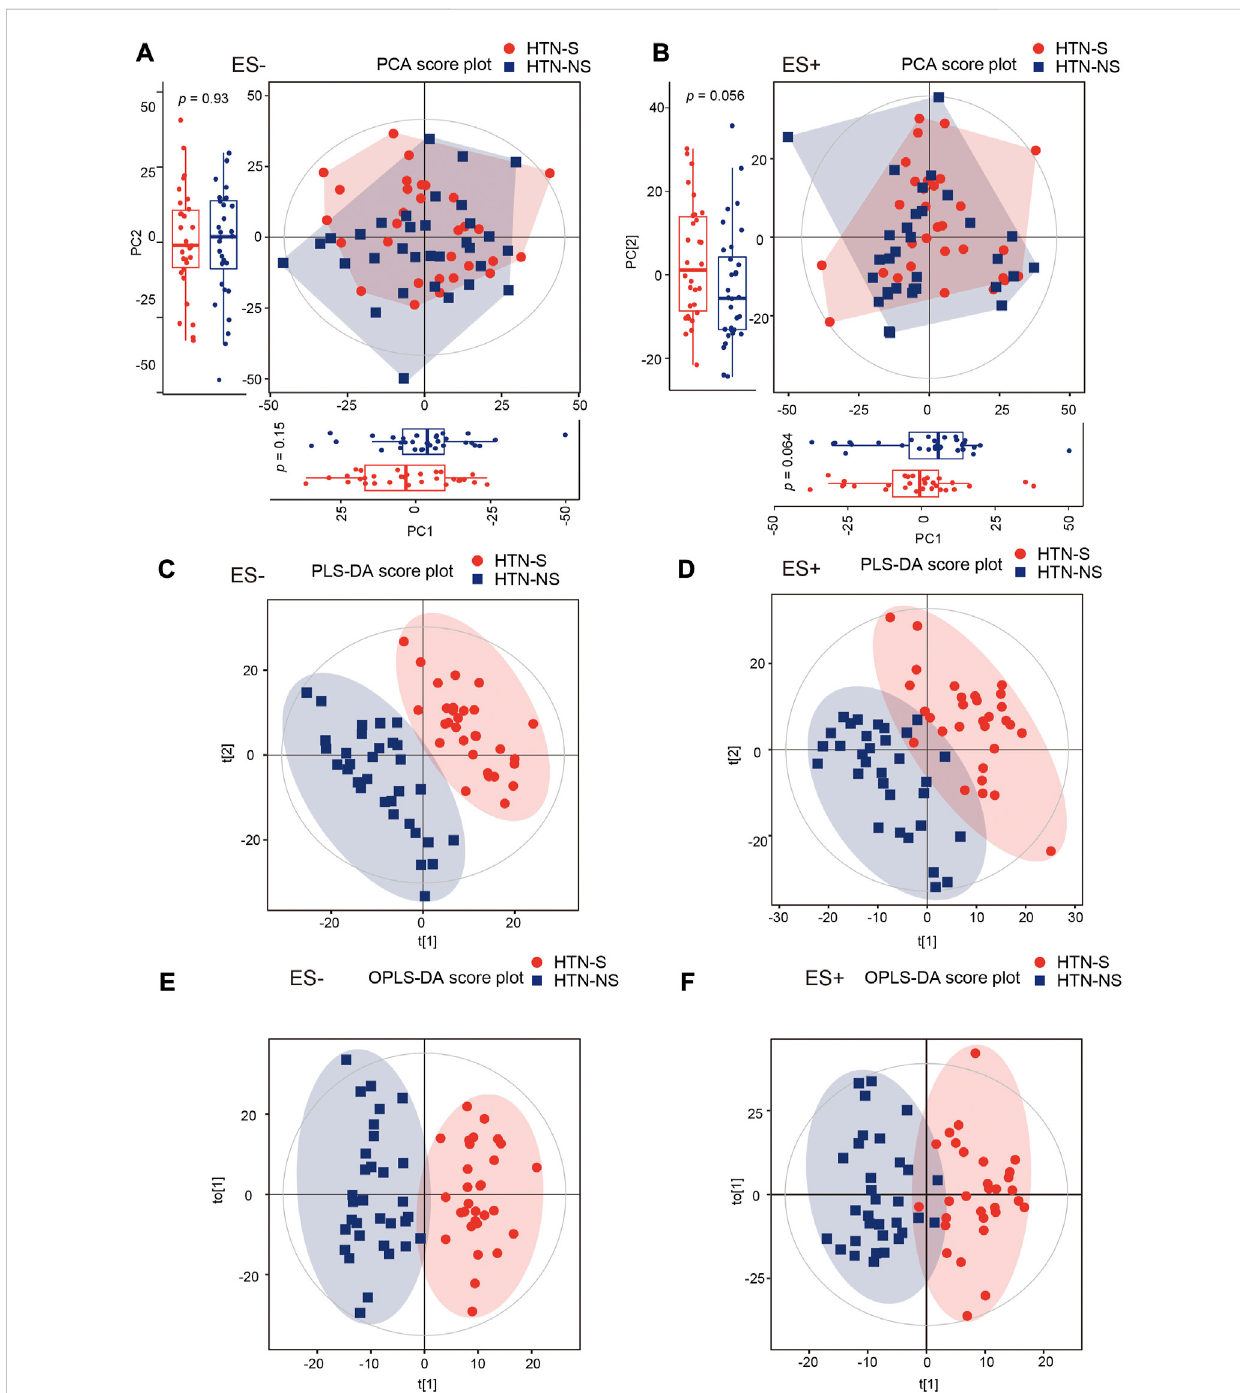
FIGURE 1 Smoking ornotconduced to dissimilarity ofserum metabolic communityinhypertensivepatients. (A,B) , Changesofoverall metabolic signaturesin hypertensive smokers as compared with non-smokers were identi fi ed with PCA score plots based on negative (ES − ) and positive (ES+) mode, respectively. Hotelling ’ s T-squared ellipse indicated 95% con fi dence interval. The distributions of samples in PC1 and PC2 coordinate axis were further shown with box plots. The fi rst and third quartile (25th and 75th percentile) was expressed with boxes, and median was represented with the inside line.Whiskersextend1.5timestheinterquartilerangefromtheouterbounds.pvalueswerederivedfromtwo-tailedStudent ’ st-test. (C,D) ,PLS-DAscore plots of both ES- and ES + mode serum metabolomic data from HTN-S patients and HTN-NS controls. Subjects from each group were completely separated. (E, F) , Score plot of the OPLS-DA showing disparate metabolic pro fi ling in HTN patients smoking cigarette or not. OPLS-DA method is a supervised multiple regression analysis for identifying discernible patterns between different groups. HTN-S, smokers with HTN; HTN-NS, non-smokers with